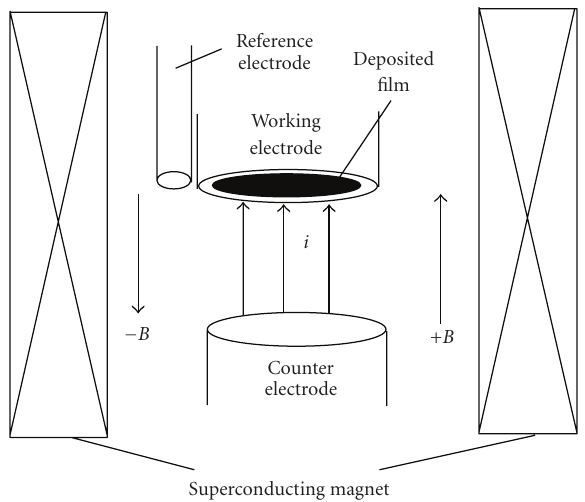
Figure 1: Schematic representation of magnetoelectrodeposition in a superconducting magnet. Magnetic fields B are applied to parallel (+) or antiparallel ( − ) to faradaic currents, and they are perpendic- ular to the electrode surface.